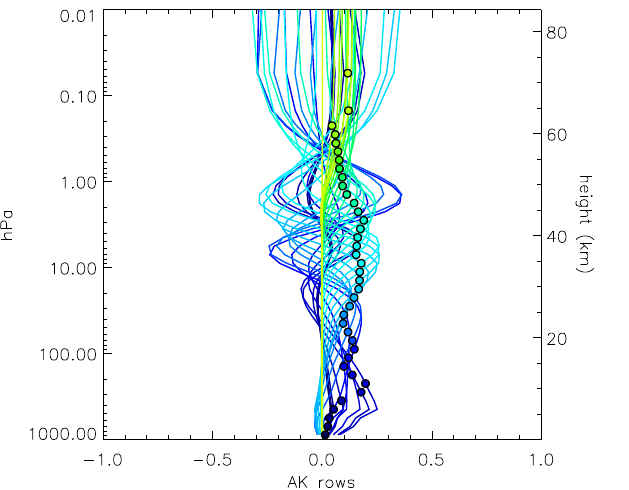
Fig. 6. Blue grid: the average of eight spectra from channels 1b/2b, the result combined with the corresponding channel 1a spectrum. Yellow grid: separate combination of each channel 1b/2b spectrum with the overlapping channel 1a spectrum. Red grid: channel 1a spectrum and one 1b/2b spectrum from one forward scan combined with the next forward scan. Green grid: channel 1a spectrum and two 1b/2b spectra from one forward scan combined with the next three forward